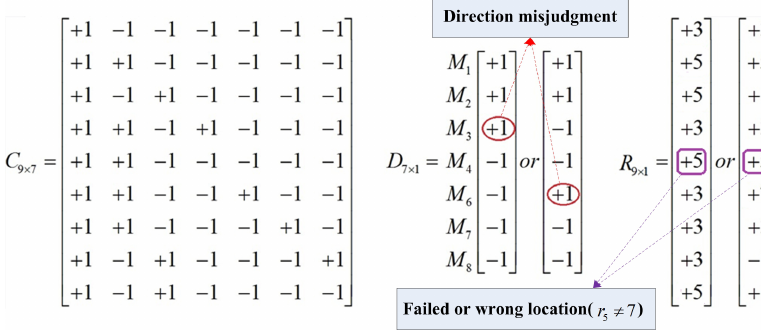
Figure 2. Failure in TVDS location with one direction misjudgment.